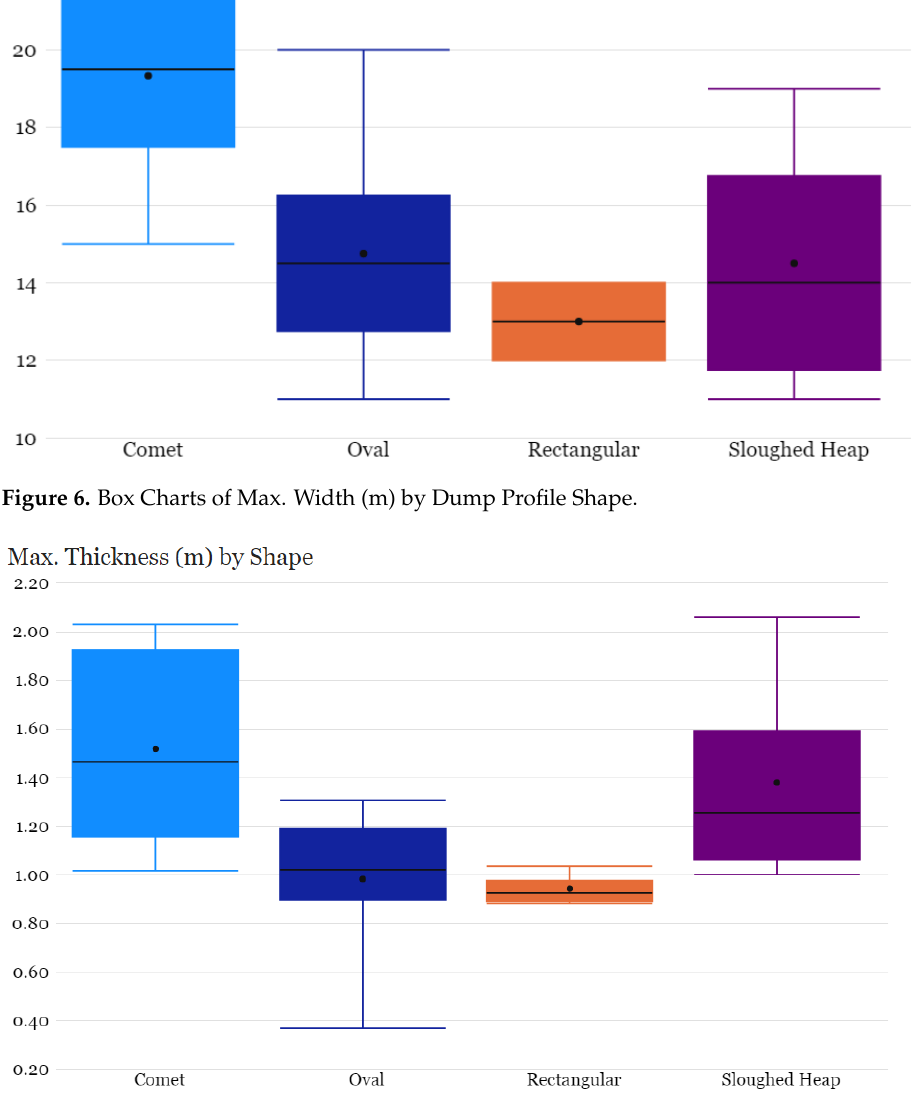
Figure 7. Box Charts of Max. Thickness (m) by Dump Profile Shape.